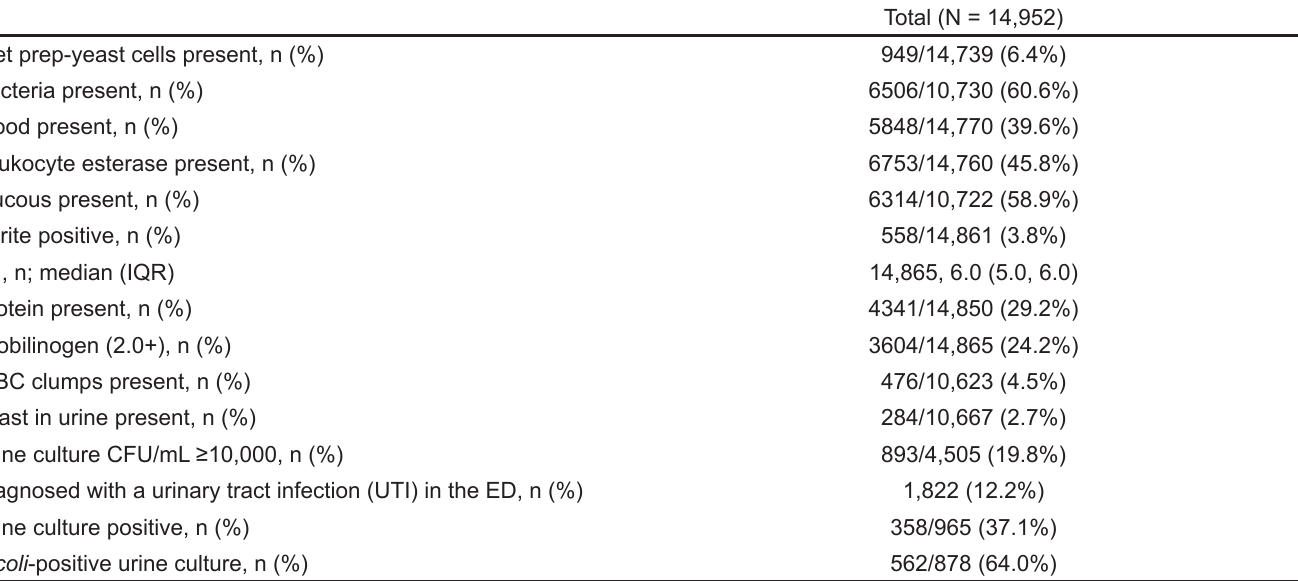
Table 2. Multivariable regression model examining the association of vaginal clue cells on vaginal wet preparation.